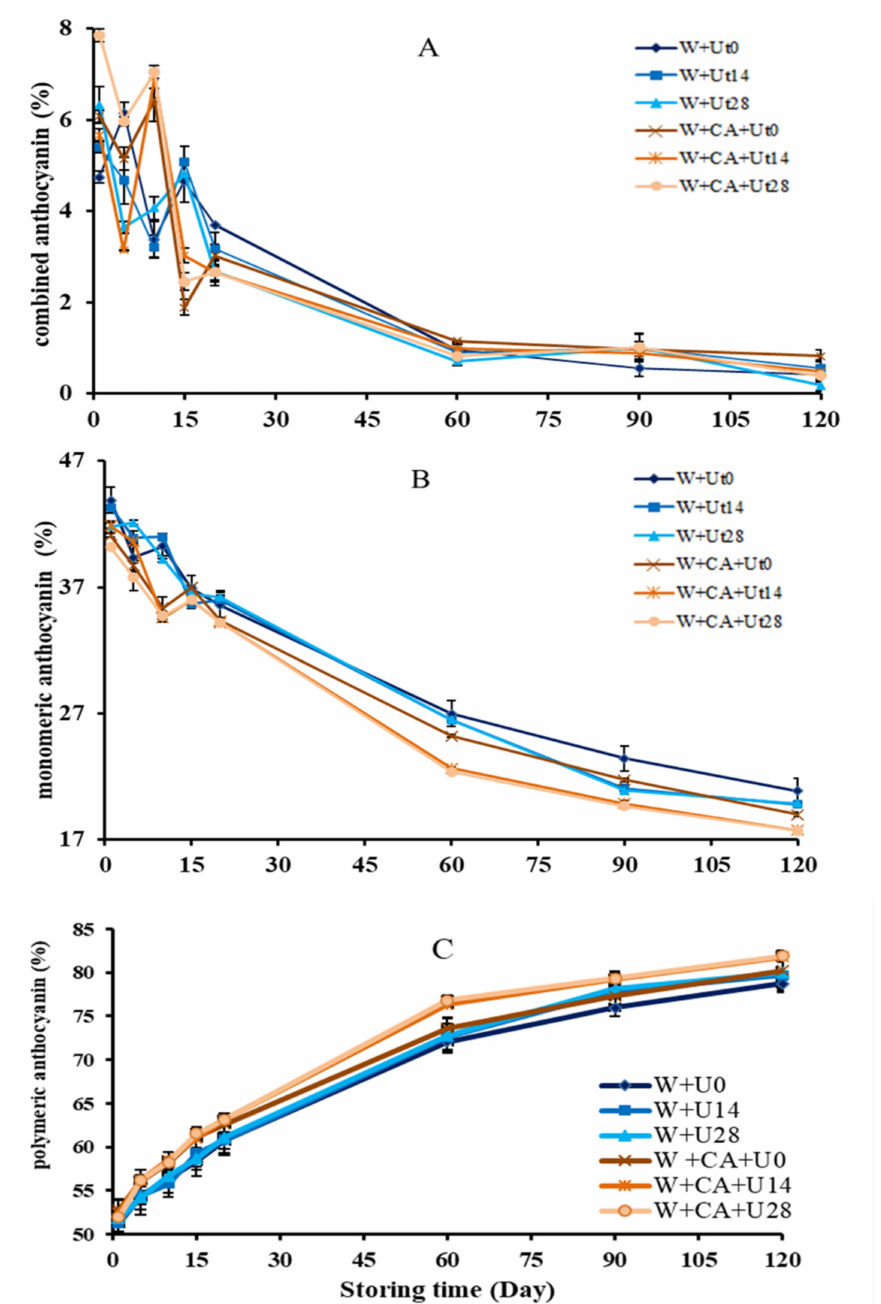
Figure 3. Evolutions of combined ( A ), monomeric ( B ) and polymeric ( C ) anthocyanins in wine samples during